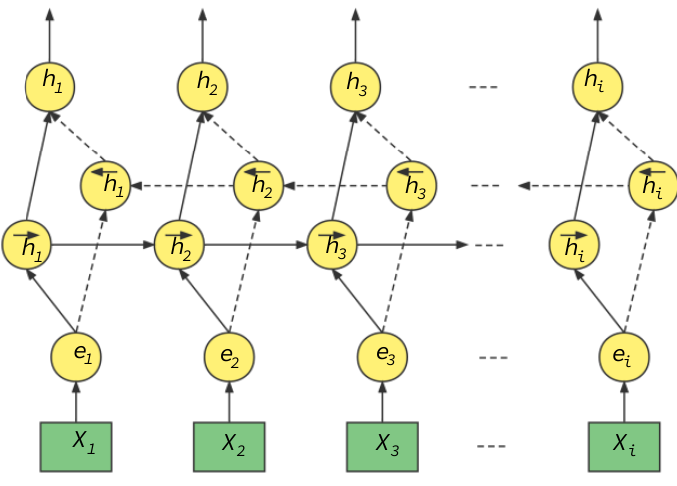
Figure 14. The network structure of the BiGRU model.